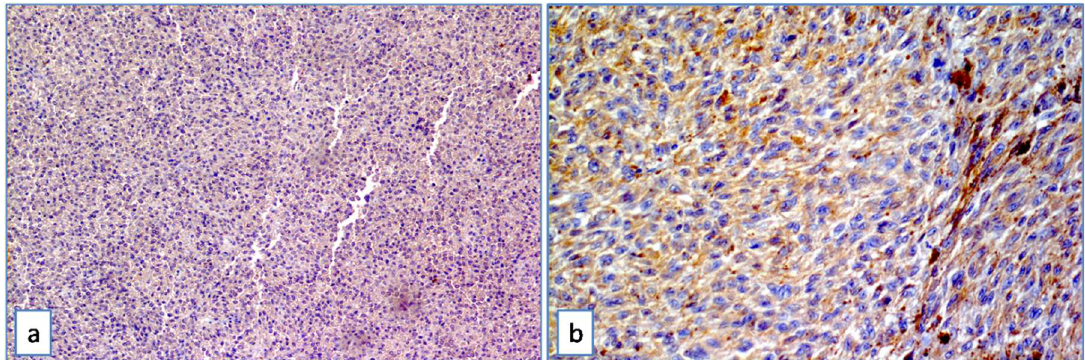
Figure 3. ABCB5 in uveal melanoma. Mild and heterogeneous cytoplasmic positivity in mixed cell type uveal melanoma at medium ( a ) and high magnification ( b ) (Immunoperoxidase stain; original magnification 100× ( a ) and 200× ( b )).